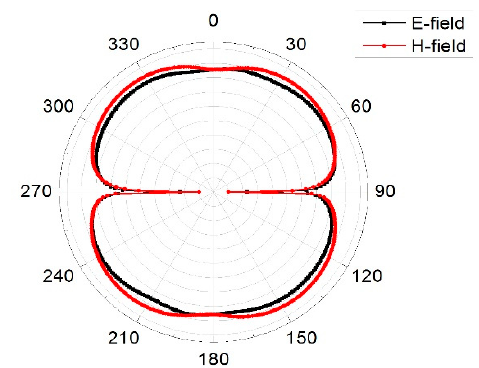
Electronics 2018 , 7 , x FOR PEER REVIEW Figure 16. Radiation pattern for mode 1 at 5.8 GHz. Figure 16. Radiation pattern for mode 1 at 5.8 GHz.